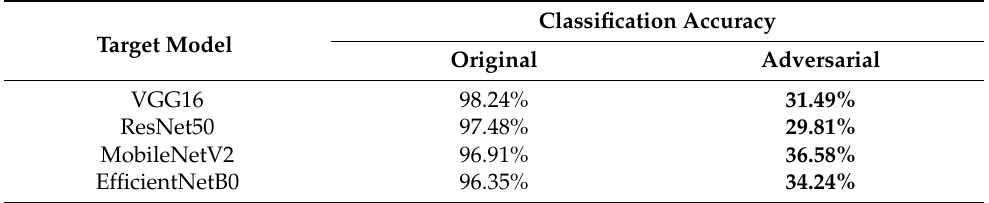
Table 3. Classification accuracy of target classification models on normal images and adversarial examples.